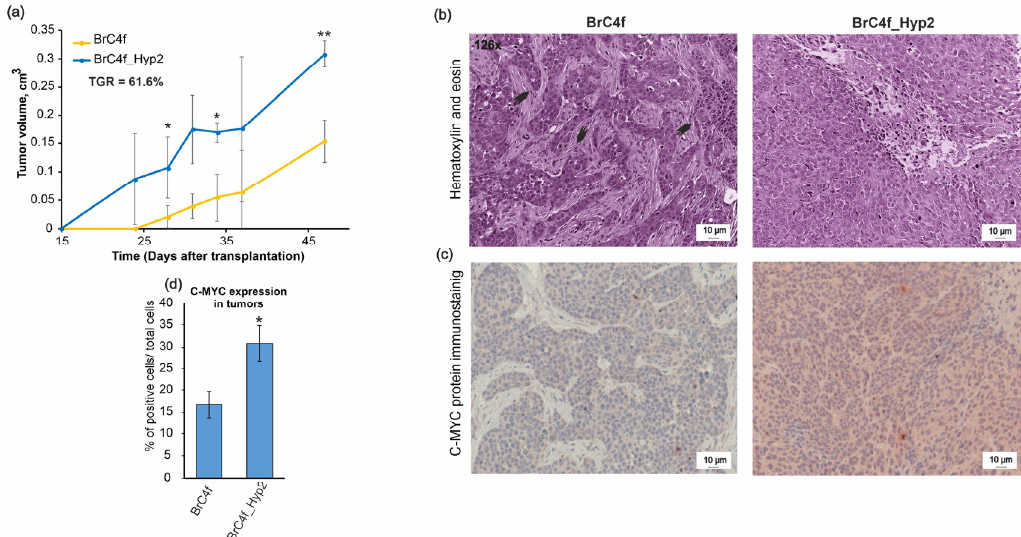
Figure 7. The tumorigenic properties of established cancer cells in vivo. ( a ) Comparison of tumor growth formed by fibroblasts transplanted into SCID mice. Tumor growth was monitored twice a week and plotted as tumor volume against time. Data are presented as mean ± SD ( n = 6 per group); statistical analysis was performed using one sample Student t-test. (*) p < 0.05, (**) p <